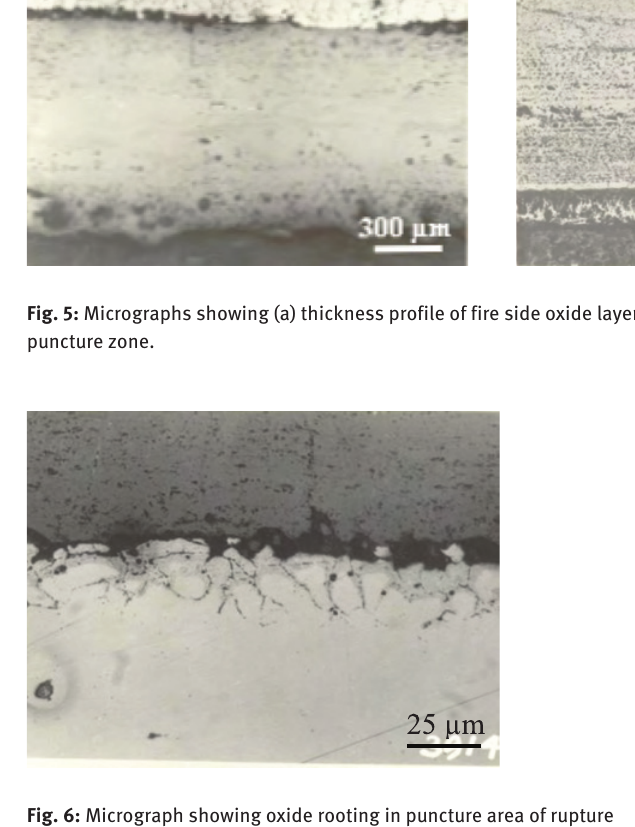
Fig. 6: Micrograph showing oxide rooting in puncture area of rupture tube.